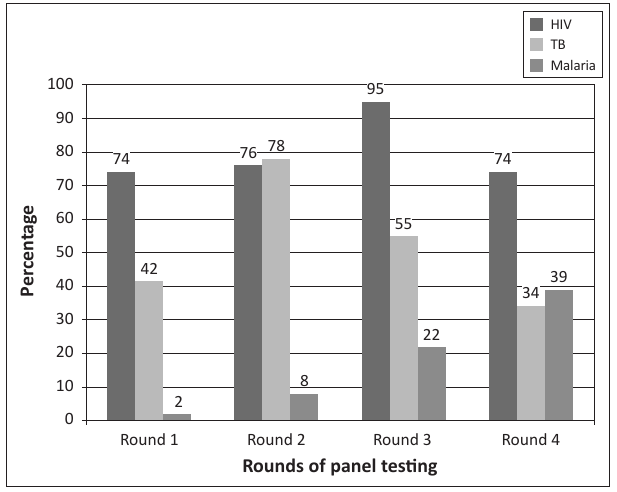
FIGURE 1: Average performance of laboratories at different rounds of panel testing.